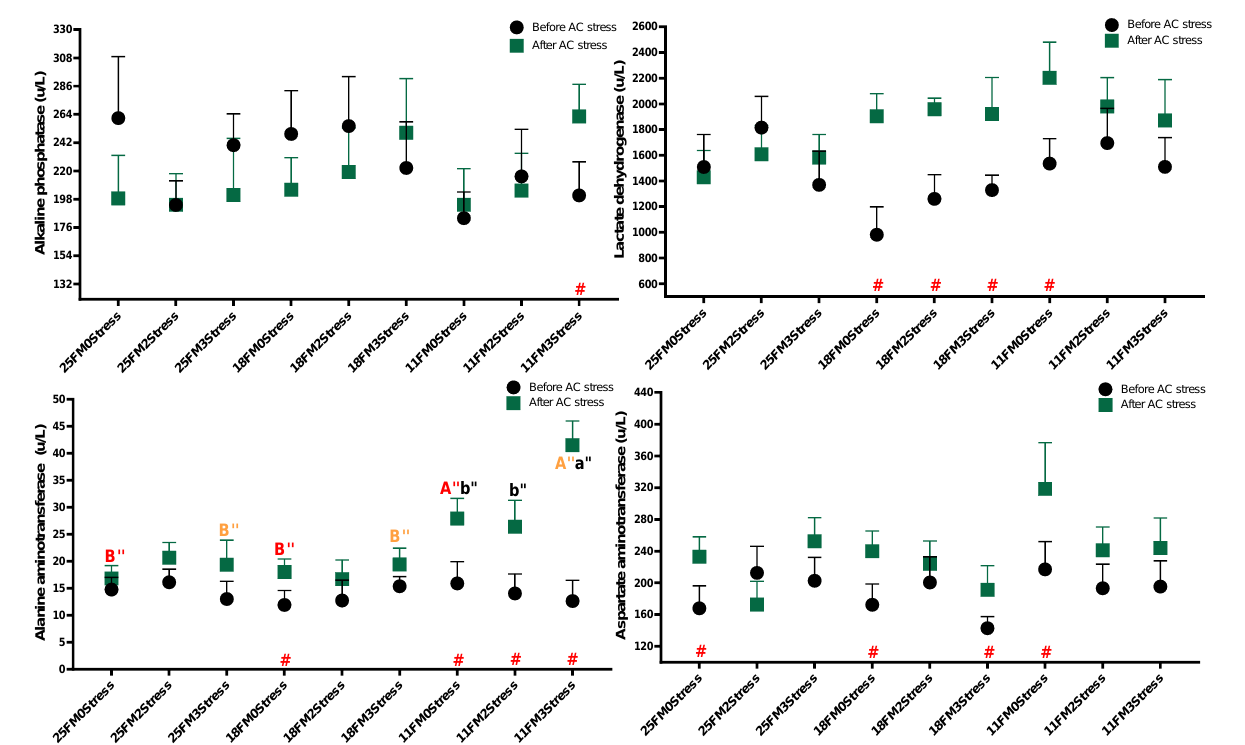
Figure 6. Liver enzyme parameters of oscar fed experimental diets containing different levels of FM and exposed to secluded early mild stress for ten weeks plus data related to after acute confinement stress (AC stress). Values are represented by means and SDM of triplicate samples. Hash (#) with green colour indicates the significant difference in each treatment before and after AC stress according to the independent sample t -test ( p < 0.05). The letters A, B and C with red, brown and orange indicate significant differences among 0Stress, 2stress and 3Stress groups after unpacking the data for the case that interaction was significant. The letters a, b and c in blue, pink and black indicate significant differences among the 25FM, 18FM and 11FM groups. The double quotation marks show that the comparison was among after AC stress groups.